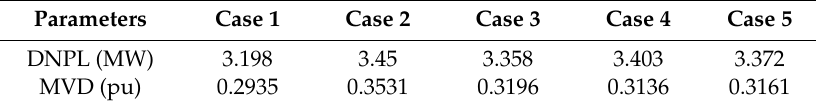
Table 8. Objective function values in different cases.